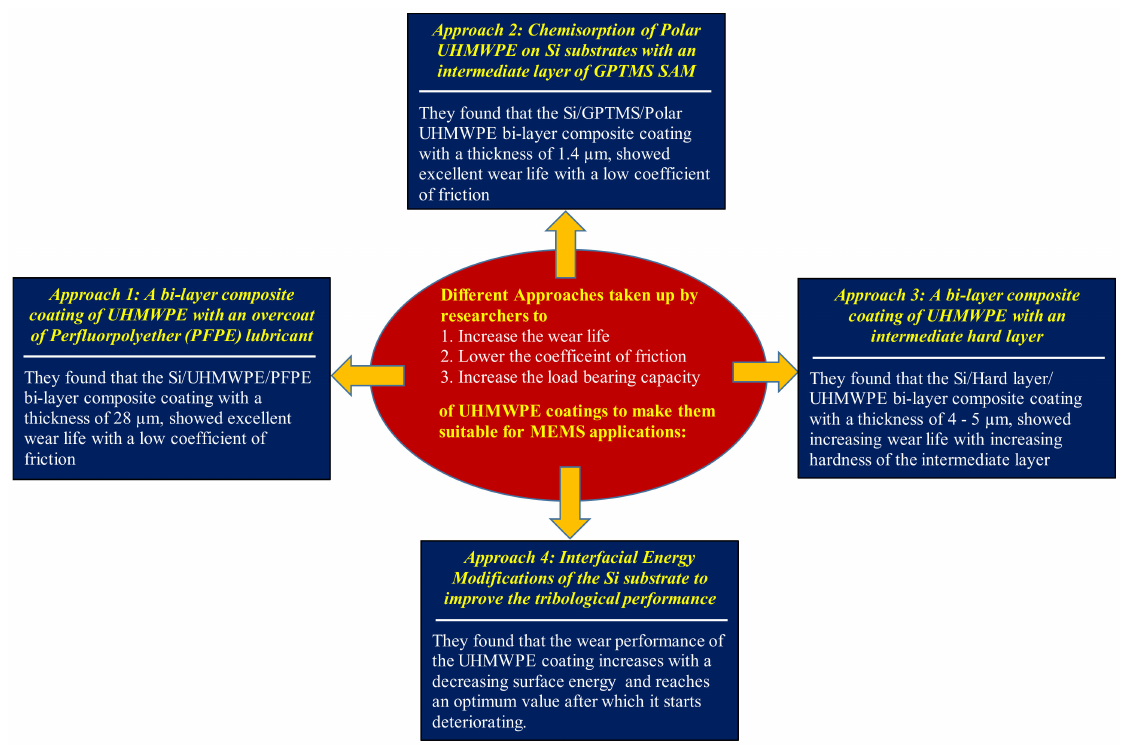
Figure 7. A summary of the different approaches taken up by the researchers to make UHMWPE coatings suitable for MEMS